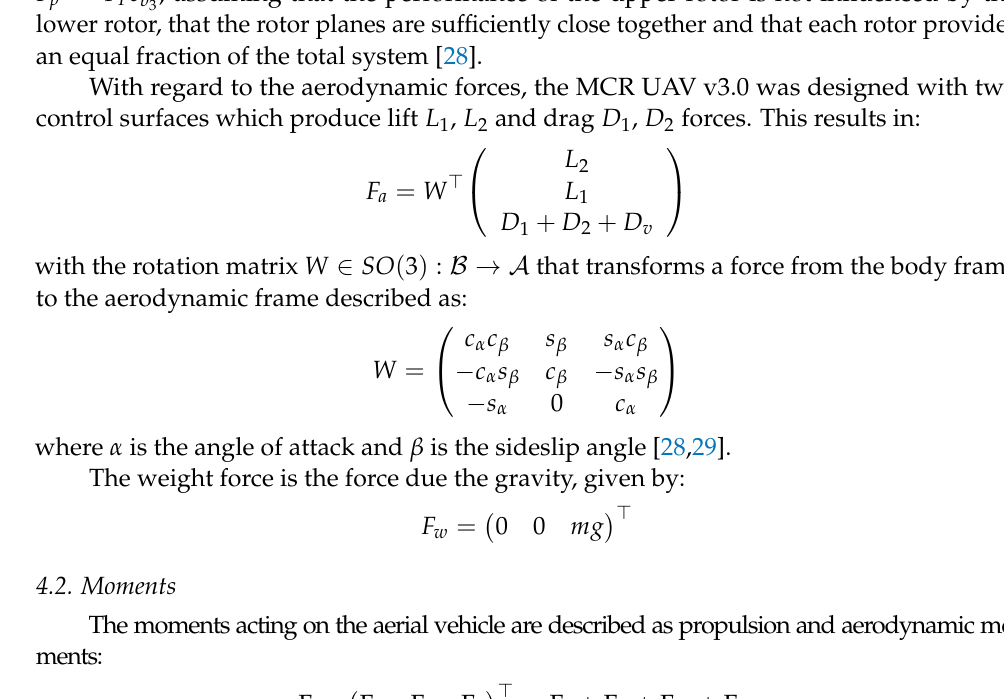
(cid:0) F p = 0 0 − T T